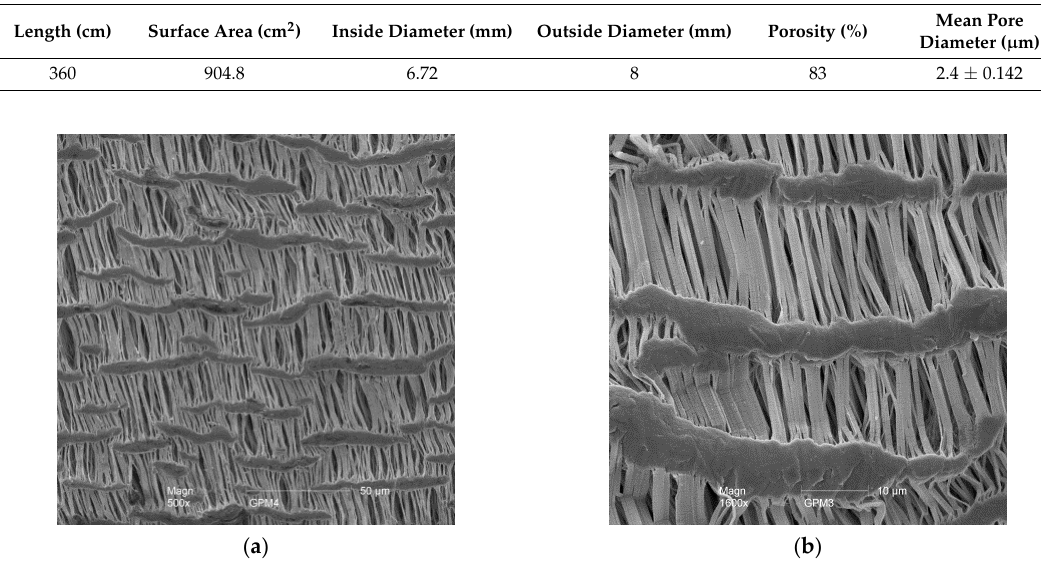
Table 2. Physical properties of the Polytetrafluoroethylene (ePTFE) gas permeable membrane used in the study. Length was measured, surface area was calculated, and all others were provided by the manufacturer.